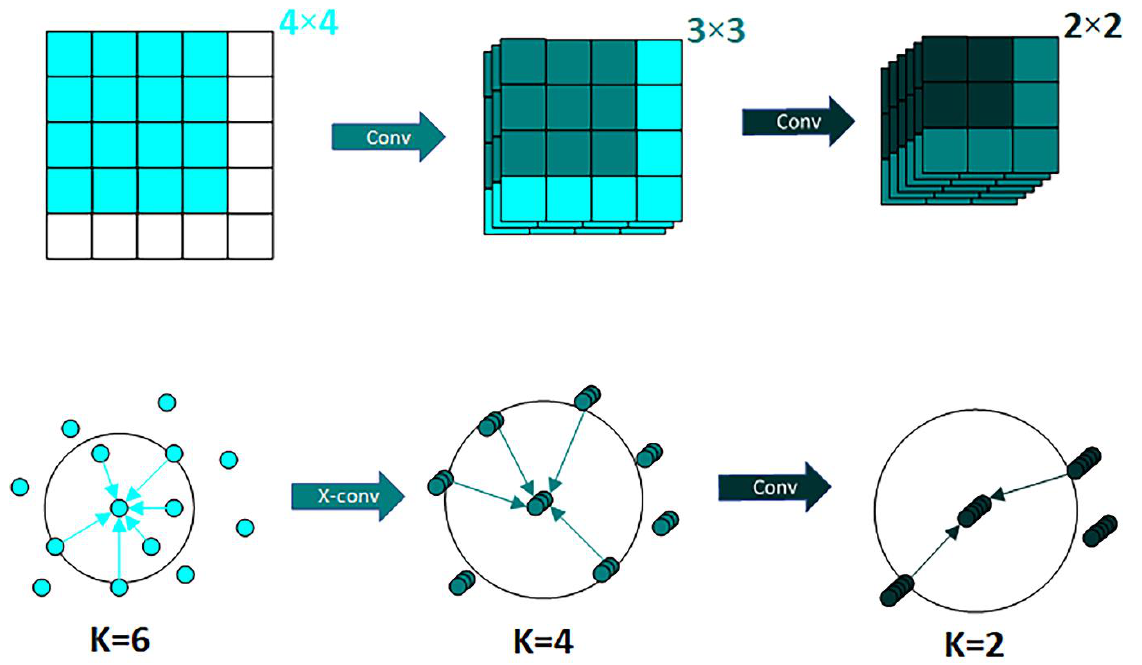
Figure 8. The different processes of CNN and PointCNN feature fusion.